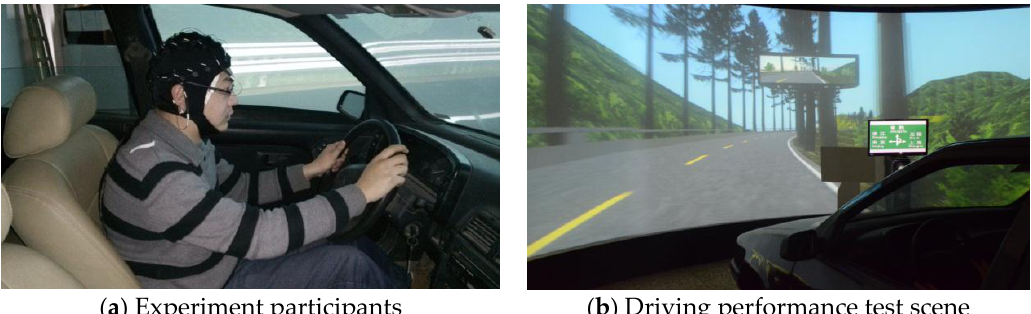
Figure 7. Driving workload test with physiological measurement.